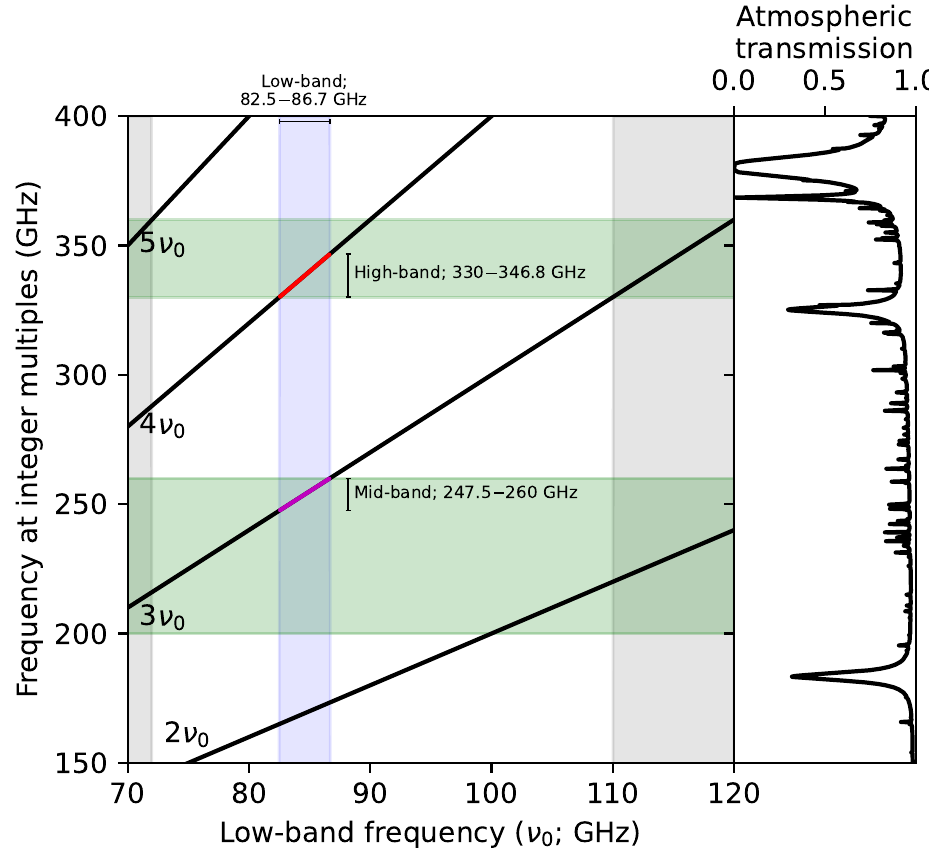
Figure 7. Frequency coverage constraints imposed by the desire to transfer phase information from a low-frequency band (“low-band”, around ∼ 86GHz) to two different higher-frequency bands (“mid-band” around ∼ 230GHz and “high-band” around ∼ 345GHz). The black curves in the left panel show integer multiples of the low-band frequency, and the green shaded regions indicate approximate available spectral windows for the mid- and high-frequency receivers. The three vertical shaded regions indicate low-band frequency ranges where an integer multiple of that frequency passes through both the mid- and high-band spectral windows. The middle vertical shaded region (highlighted in blue) corresponds to our proposed spectral arrangement; the available frequency ranges for each of the three bands are labeled, and the corresponding segments of the black curves are highlighted. For reference, the right panel shows the atmospheric transmission as a function of